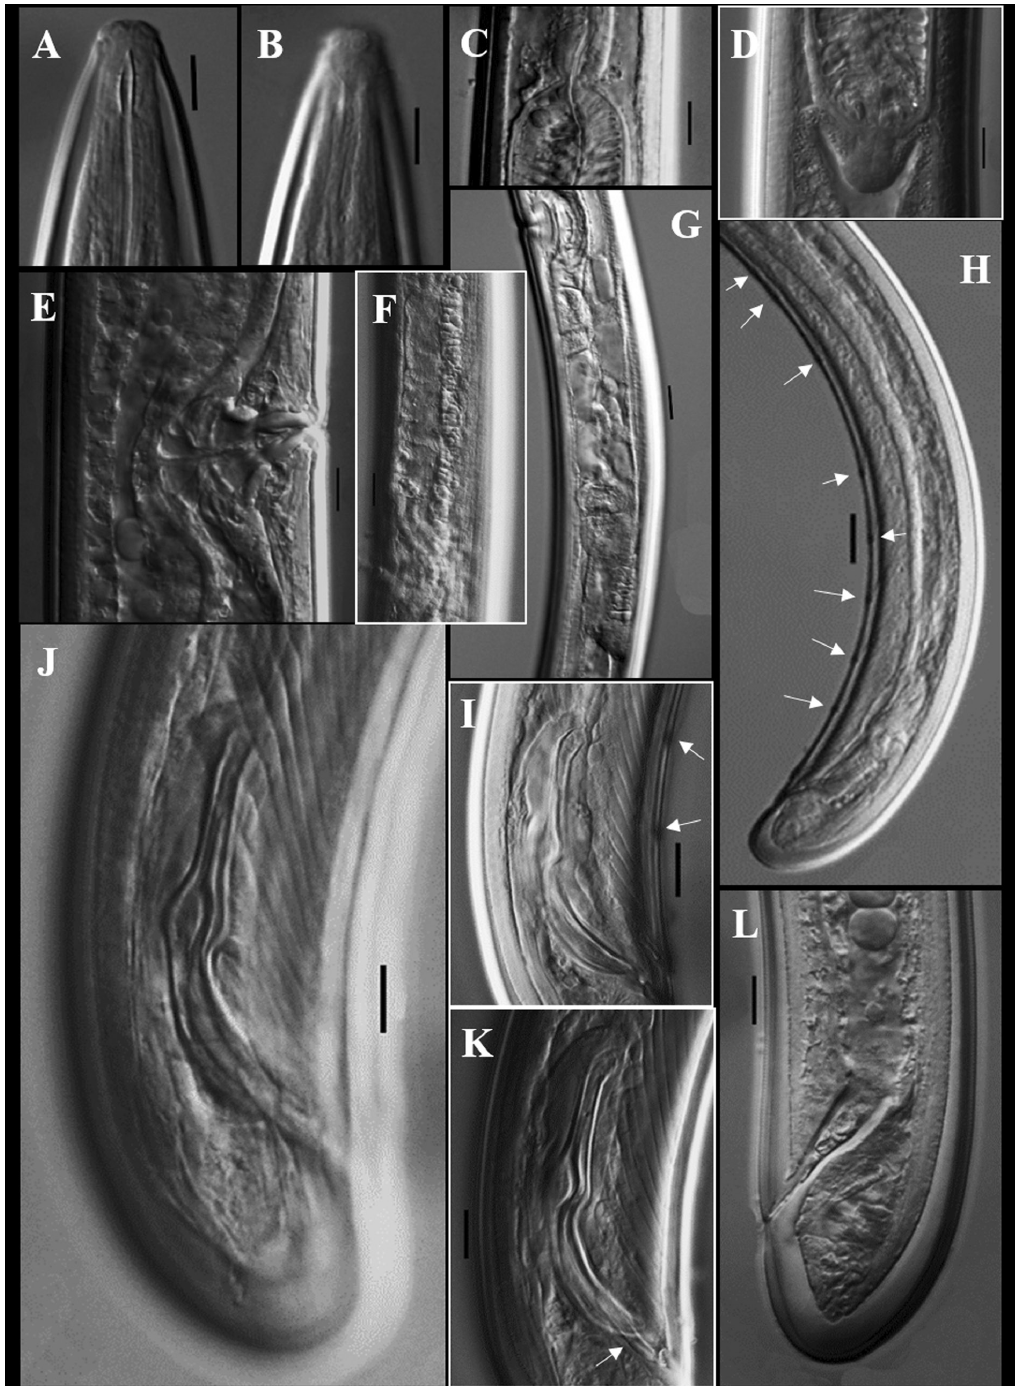
Fig. 16. Axonchium uniqum sp. nov. (LM photographs). A – B , E , L . Holotype, ♀ (AMU/ZD/ Axonchium uniqum sp. nov. /1). C – D , F – G . Paratype 2, ♀ (slide 3). H – K . Paratype 3, ♂ (slide 3). A . Anterior region. B . Anterior end showing amphid. C . Junction between anterior and posterior expanded part of